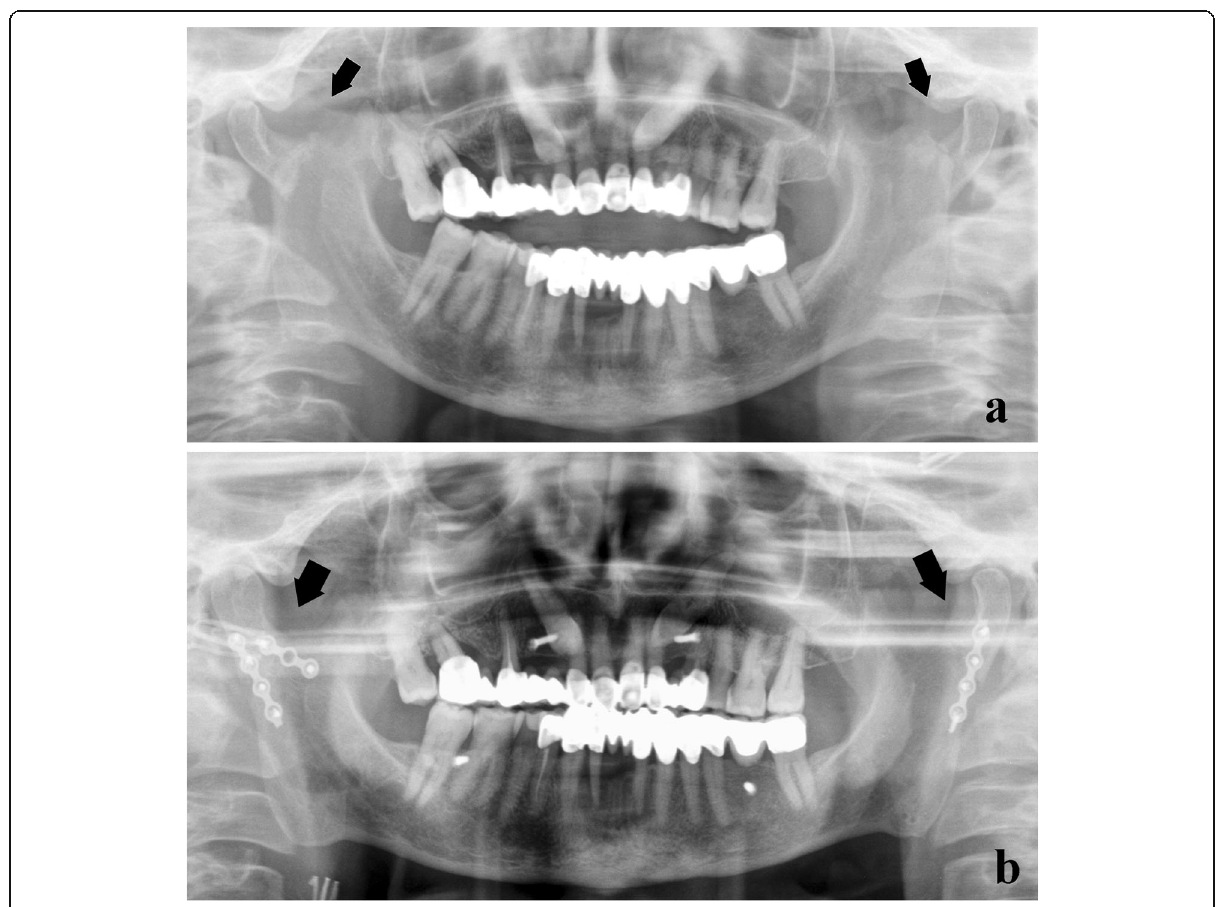
Fig. 21 Bilateral condylar process fracture with extracapsular lateral dislocation. a Panoramic radiograph shows a fracture of both condylar necks (arrows), following a violent trauma on the chin symphysis. b The lateral displacement of the condylar heads was subjected to “ open ” reduction and rigid internal fixations with osteosynthesis plates